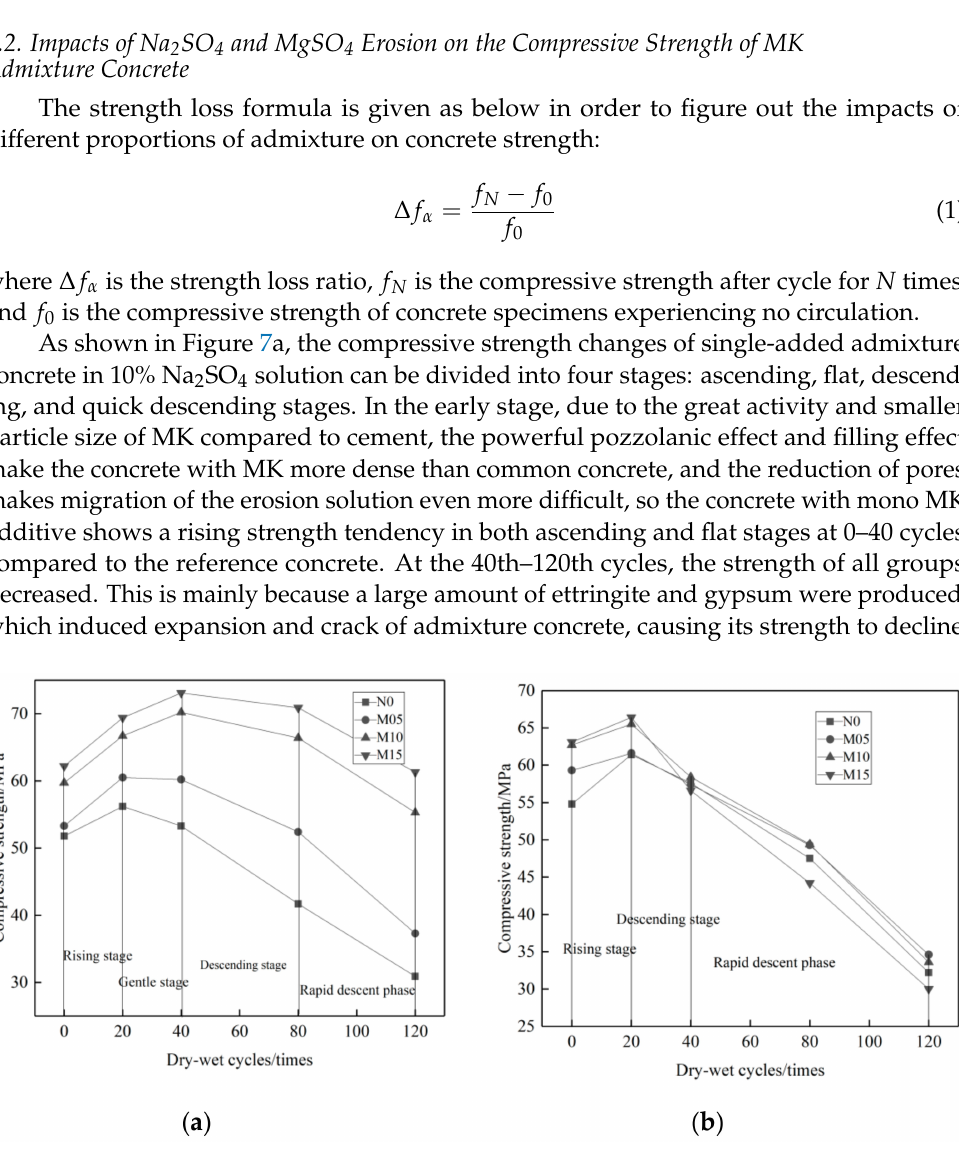
Figure 7. Variation curve of compressive strength of MK concrete with erosion times under different erosion conditions. ( a ) 10% Na 2 SO 4 , ( b ) 10% MgSO 4